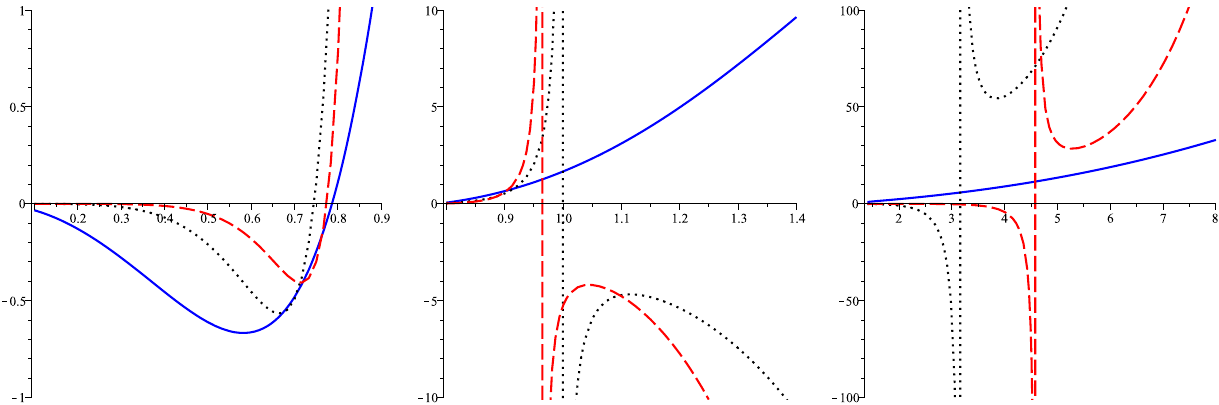
Fig. 2 C Q versus r + for k = 1, q = 1, P = 1 / 8 π , d = 4 (solid lines), d = 7 (dotted lines) and d = 9 (dashed lines). Different scales: left panel (0 < r + < 0 . 9), middle panel (0 . 8 < r + < 1 . 4) and right panel (1 . 4 < r + < 8)